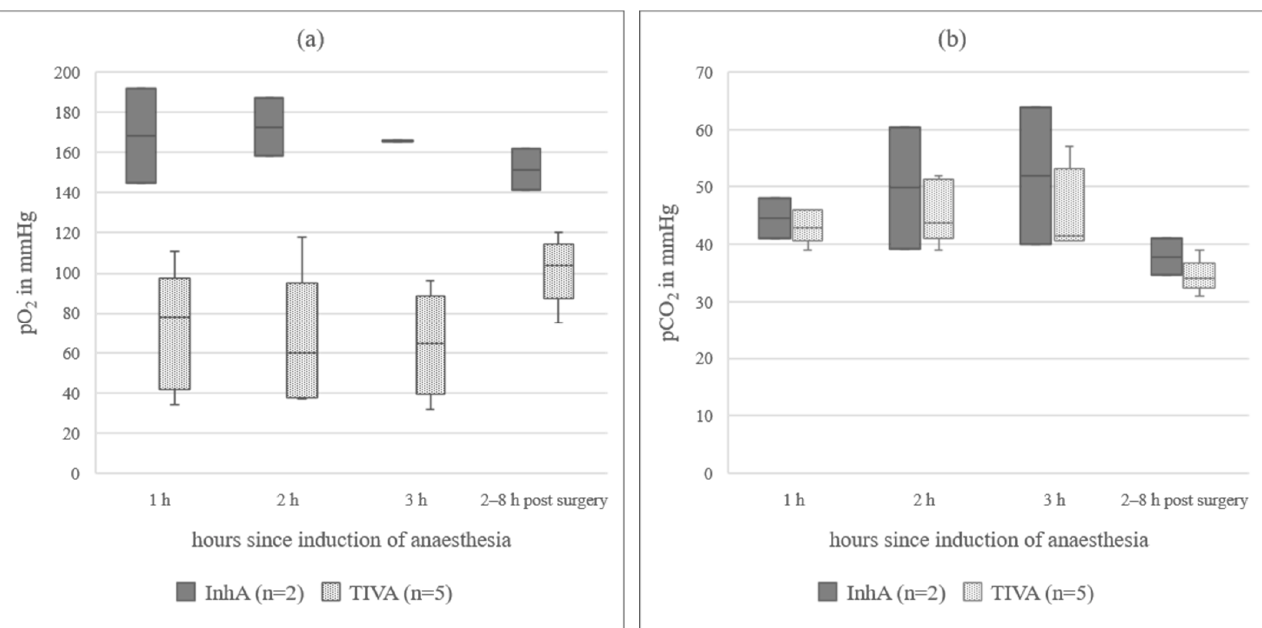
Figure 1. ( a ) pO 2 in arterial blood in sheep during three hours of anaesthesia ; InhA = inhalational anaesthesia, TIVA = total intravenous anaesthesia; the boxplots represent the interquartile range and the respective maximum and minimum, together with the median. ( b ) pCO 2 in arterial blood in sheep during three hours of anaesthesia ; InhA = inhalational anaesthesia, TIVA = total intravenous anaesthesia; the boxplots represent the interquartile range and the respective maximum and minimum, together with the median.